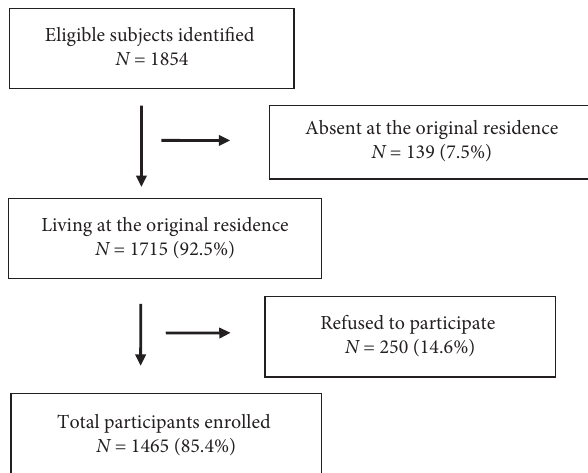
Figure 1: Workflow of participants’ inclusion and